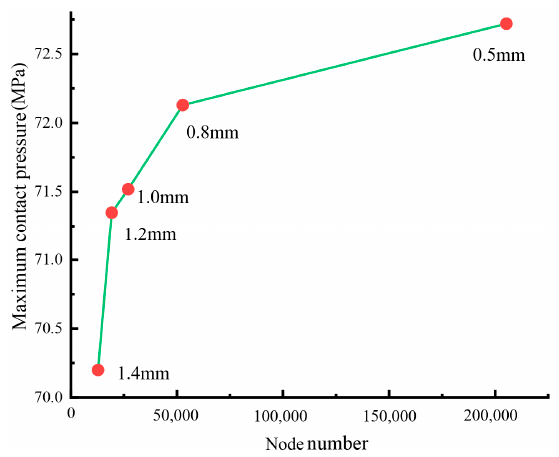
Figure 13. The lapped plate under mixed-mode loading.